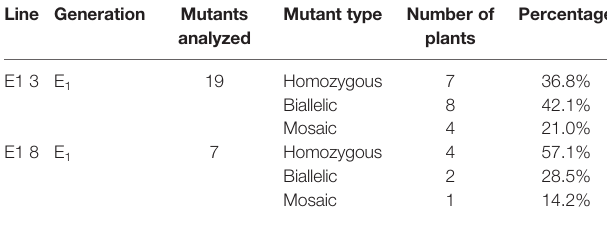
TABLE 2 | Summary of eIF4E1 CRISPR/Cas9 ‐ induced mutations in E 1 lines. Line